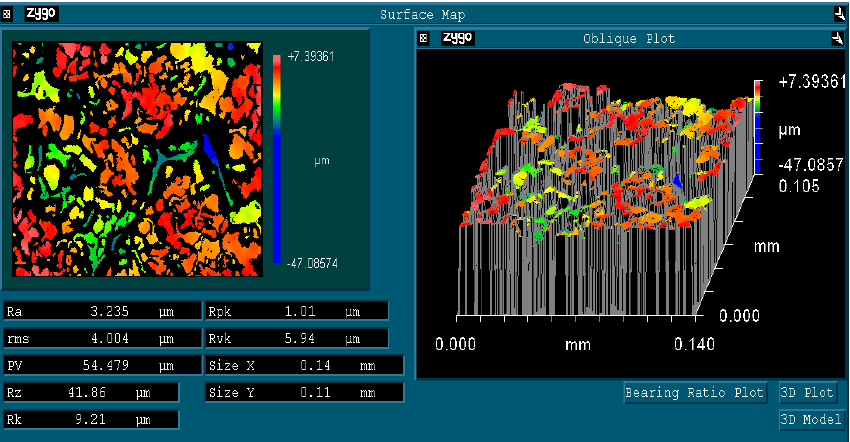
Figure 2. An example of the roughness image for surfaces with high nominal values of an asperity size (the nominal asperity size is 9 µ m). The white light interferometry was not able to provide data for considerable number of